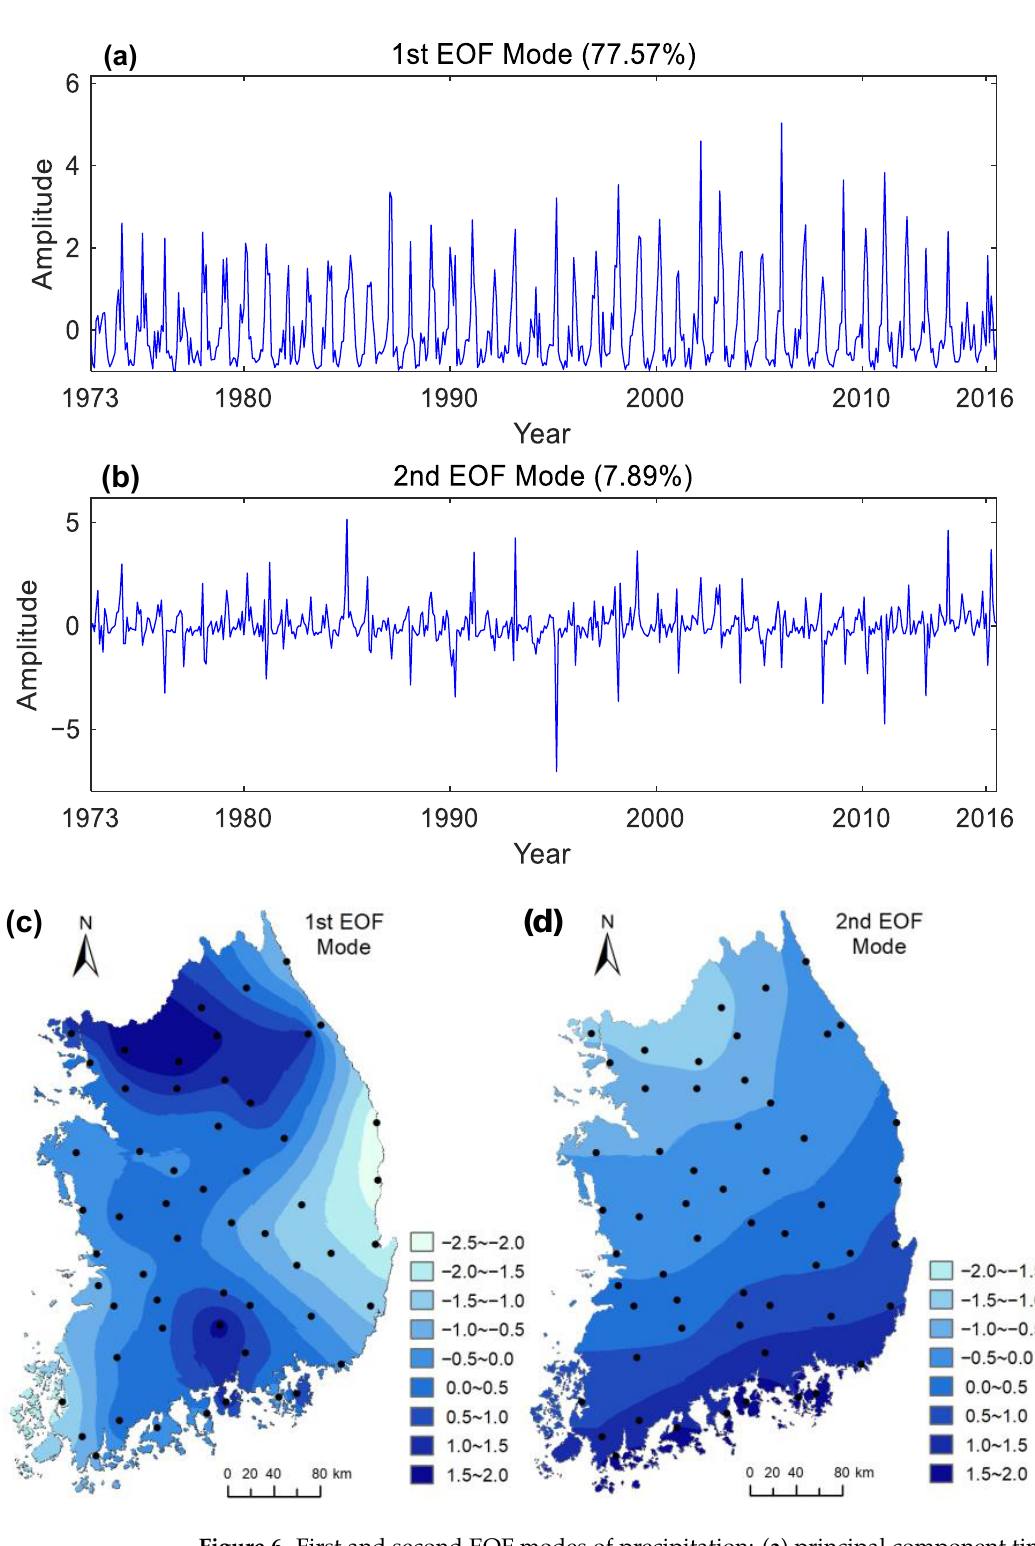
Figure 6. First and second EOF modes of precipitation: ( a ) principal component time series of 1st EOF mode, ( b ) principal component time series of 2nd EOF mode, ( c ) loading vectors of 1st EOF mode, ( d ) loading vectors of 2nd EOF mode.